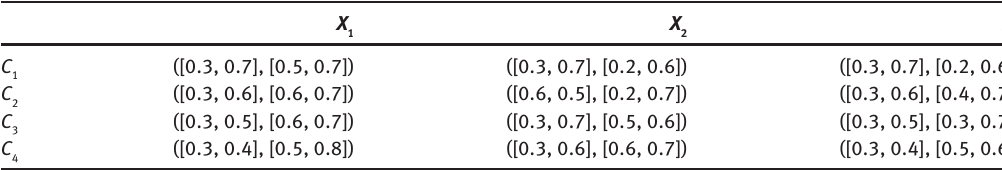
Table 8: Pythagorean Fuzzy Ordered Decision Matrix R 1 .